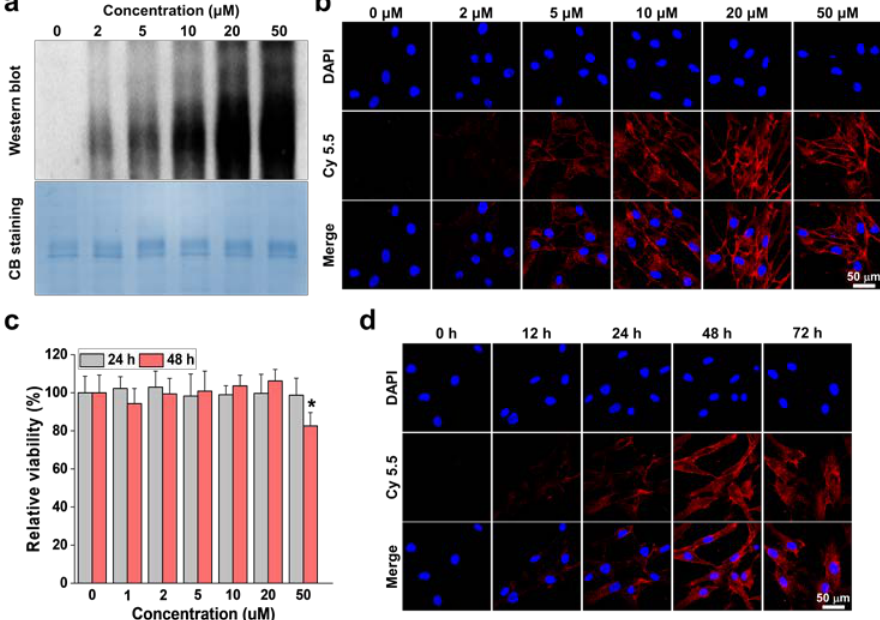
Figure 2. Optimization for the generation of azide groups on the stem cell surface. ( a , b ) N 3 generation in the MSCs after 48 h treatment of Ac4ManNAz with concentrations from 0 to 50 μM, confirmed by ( a ) Western blot analysis and ( b ) fluorescence imaging, respectively. ( c ) The viability of MSCs after 48 h of Ac4ManNAz treatment with concentrations from 0 to 50 μM. ( d ) N 3 generation in the MSCs after 20 μM treatment of Ac4ManNAz with different incubation times, * p < 0.05.